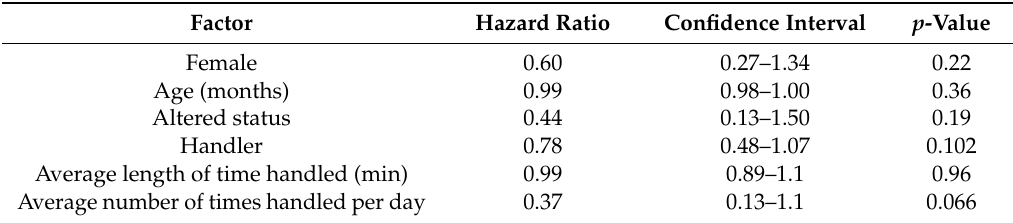
Table 1. E ff ect of various factors on the hazard of developing upper respiratory disease in cats staying at a shelter. p -value < 0.05 considered significant.